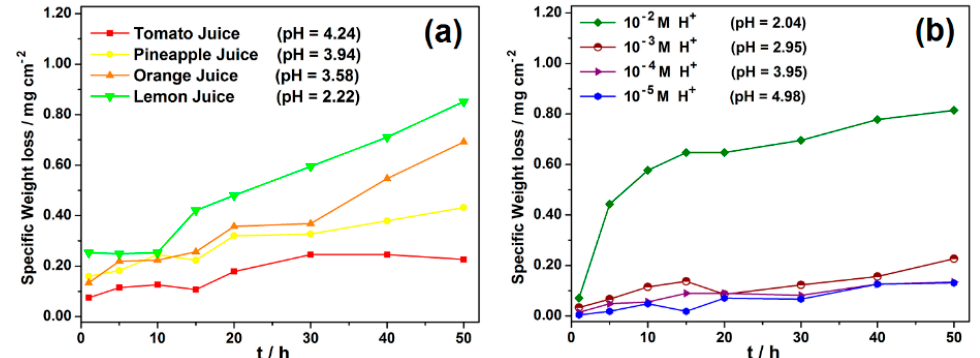
Figure 3. Plot of specific weight loss as a function of immersion time, respectively, for carbon steel in ( a ) different fruit juices and ( b ) HCl solutions of comparable pH.